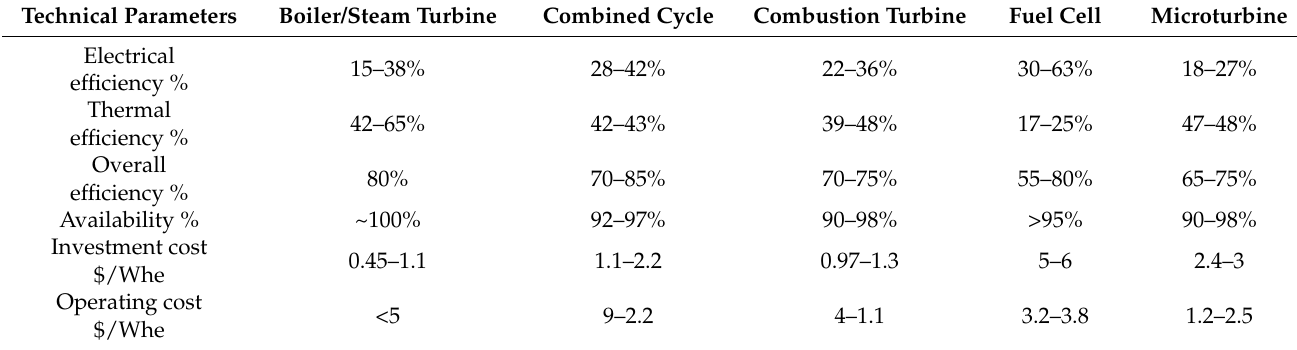
Table 5. Comparison between cogeneration energy production systems.